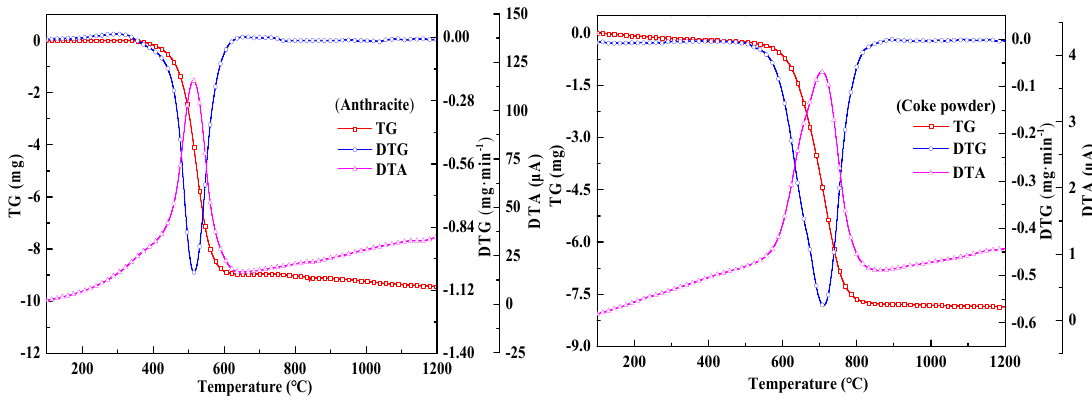
Figure 4. Thermogravimetric curves of anthracite and coke.